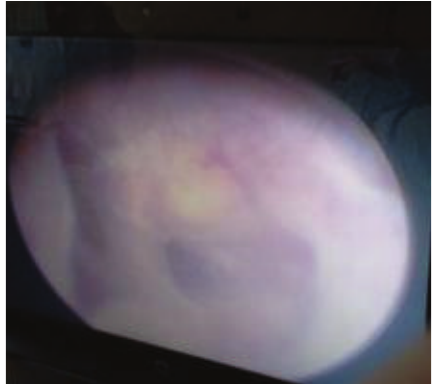
Figure 2: Cystoscopy result showing diverticulum near the bladder